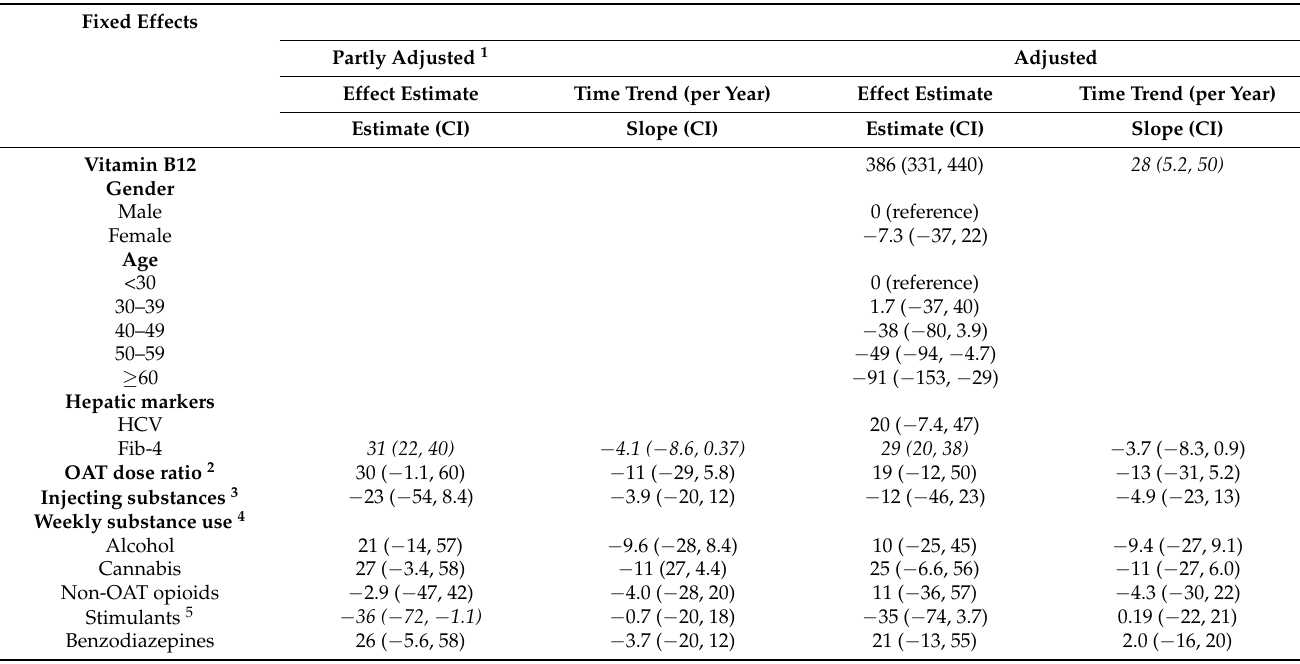
Table 2. Linear mixed model of serum vitamin B12 concentration (pmol/L) adjusted for sociodemo- graphic and clinical factors, including substance use